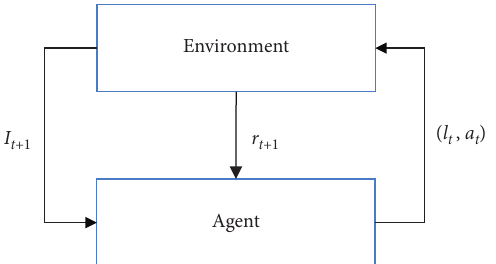
Figure 6: Reinforcement learning used for thedetection and classification policy ofwall defect detection. The agent outputs a location action l an environment action a t when it interacts with the environment. In return, the environment gives the agent the next state I t +